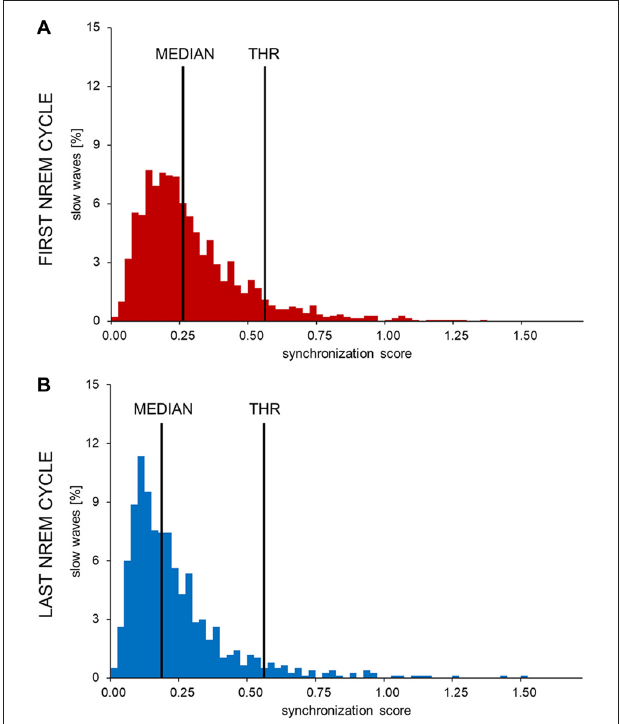
FIGURE 2 | Histograms showing the distribution of synchronization scores (SS) in one representative subject. The SSs observed in the first (A) and last (B) sleep cycle were divided in 0.025 SS-units bins to obtain these images. The y-axis shows the percentage of all detected waves in each bin. In all subjects and examined conditions the SS showed a non-normal, skewed distribution. The long, sparse, right tail of the distribution is compatible with the presence of highly synchronized slow waves. An arbitrary threshold to distinguish between potential type I and type II slow waves (THR) was set at three median absolute deviations (MAD) from the median of the early SS